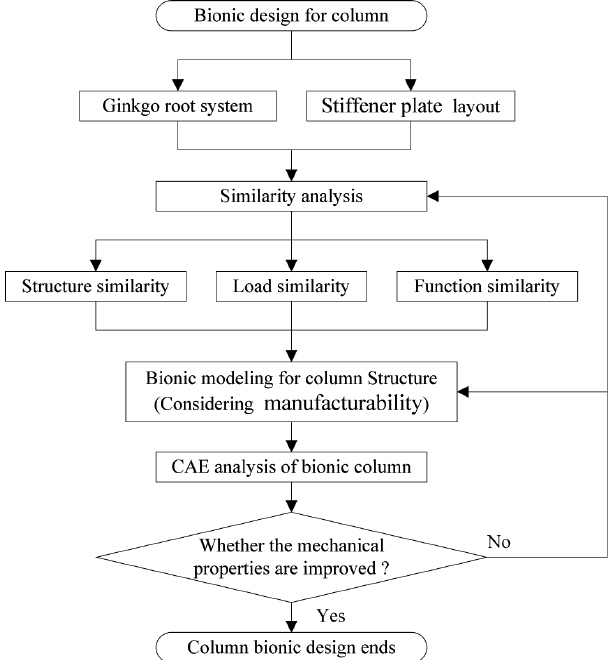
Fig. 2. Column structural bionics design